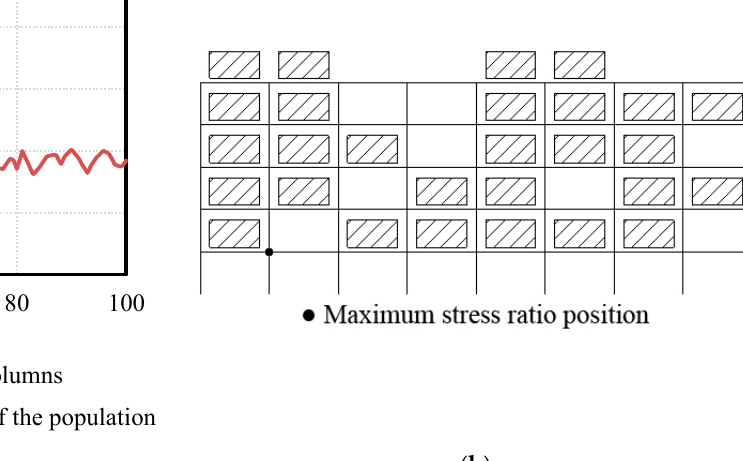
Figure 13. The most unfavorable distribution of load under 70% full load. ( a ) Tracking chart of optimization performance of GA. ( b ) The most unfavorable distribution of load (H = 2.86, P = − 0.18).